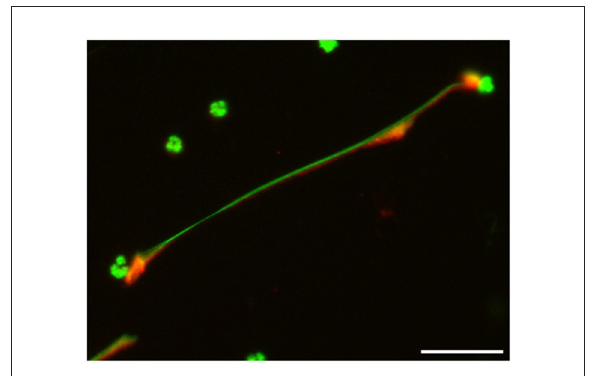
FIGURE4 Tamoxifen triggers netosis mainly of the sprNETS type. Representative fluorescence of equine PMNs treated with TX (10 µ M) and marked with DNA staining PicoGreen TM . Strand-like NETs structures marked with PicoGreen TM (green) and citrullinated histone H4 antibody (red). Note the formation of sprNETs (consist of smooth, elongated, cobweb-like structures of decondensed chromatin, composed exclusively of fine fibers). Scale bars = 30 µ m.